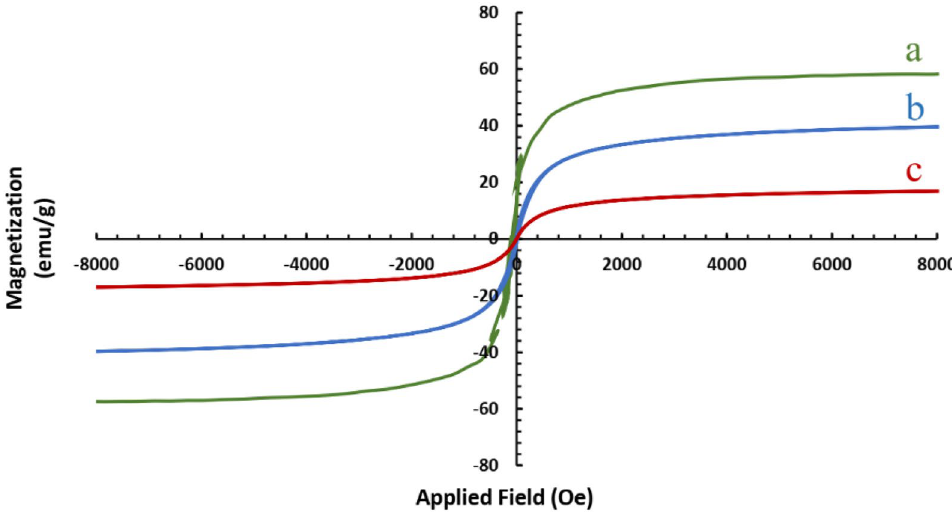
Figure 7. VSM analysis of Fe 3 O 4 ( a ), Fe 3 O 4 @SiO 2 -PrNH 2 ( b ), Fe 3 O 4 @SiO 2 @TAD-G3 ( c ).